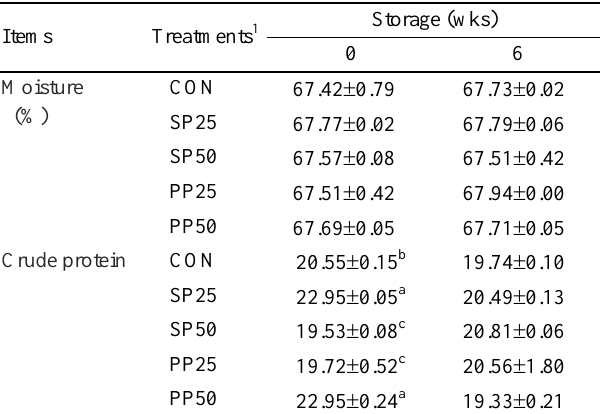
Table 2. Proximate composition of cooked pork sausages